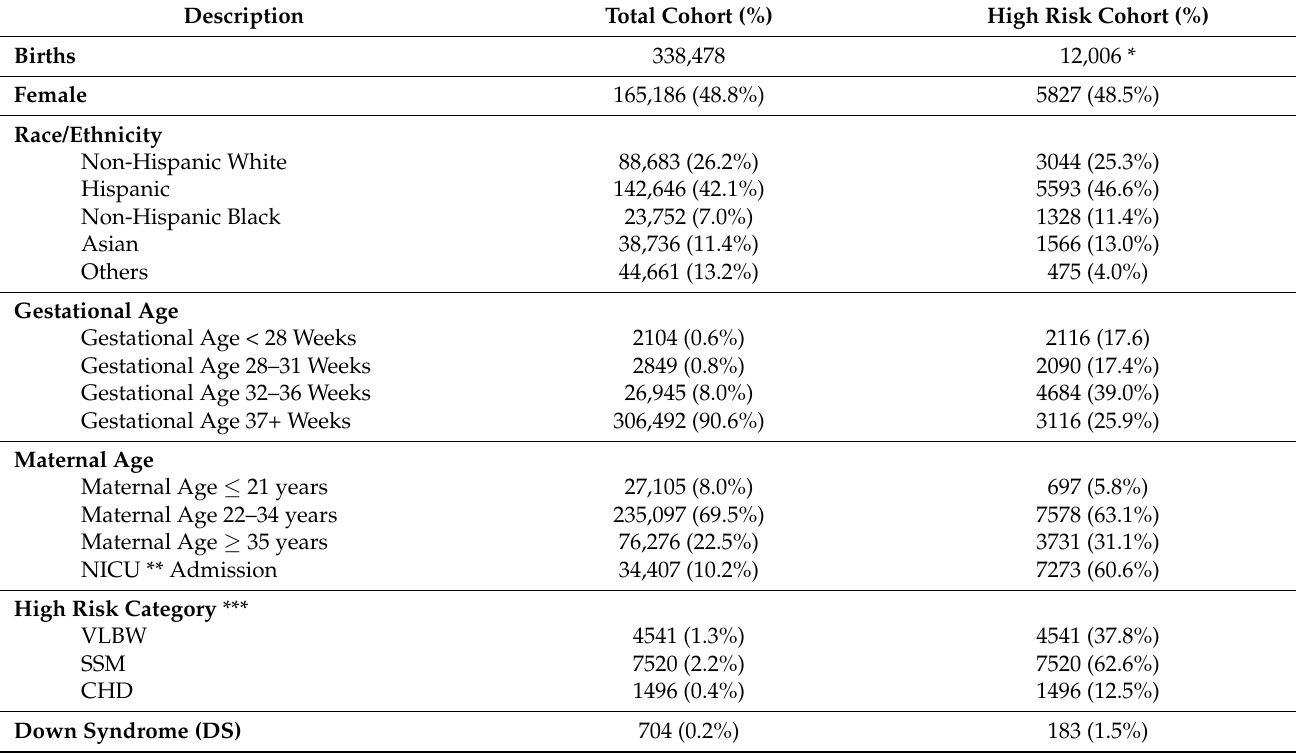
Table 1. Demographic characteristics of cohort 2010–2018.